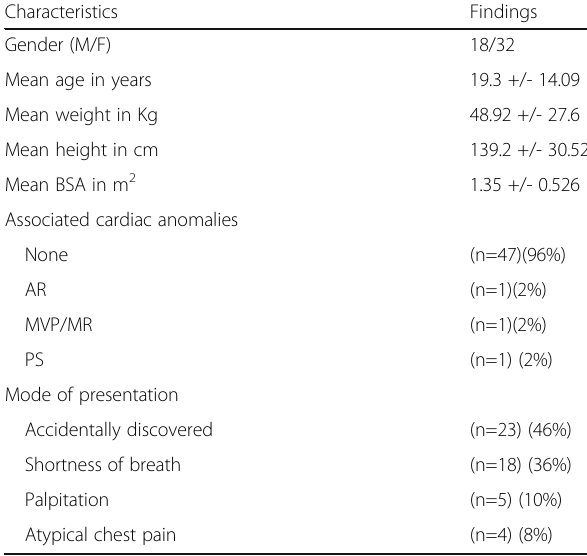
Table 1 Clinical and demographic characteristics of the